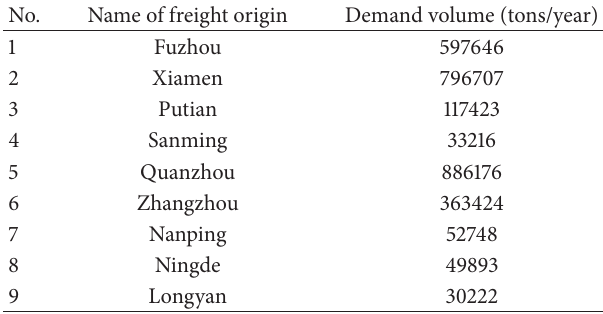
Table 2: Hinterland freight origins in Fujian province.